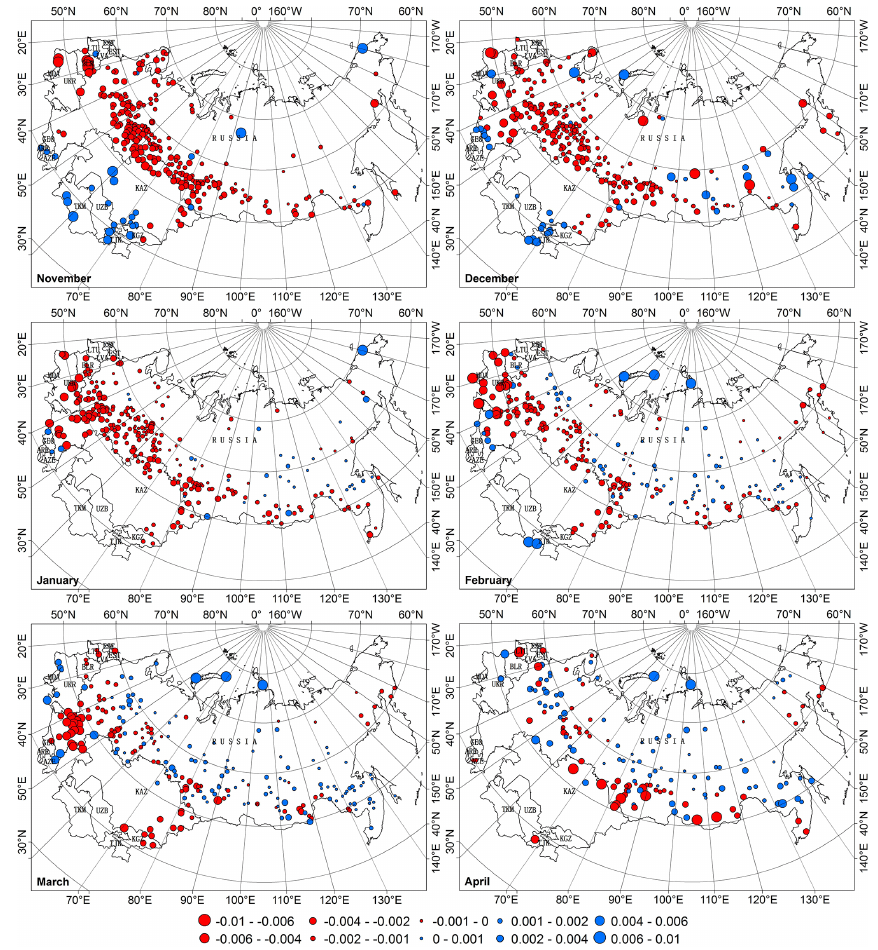
Fig. 9. Spatial distributions of linear trend coefficients (gcm − 3 yr − 1 ) of monthly mean snow density (from November to April) for each station during 1966–2008. The rates of changes in monthly mean snow density are statistically significant at p < 0 . 05 significant level. Red circles represent decreasing trends while blue circles denote increasing trends in snow